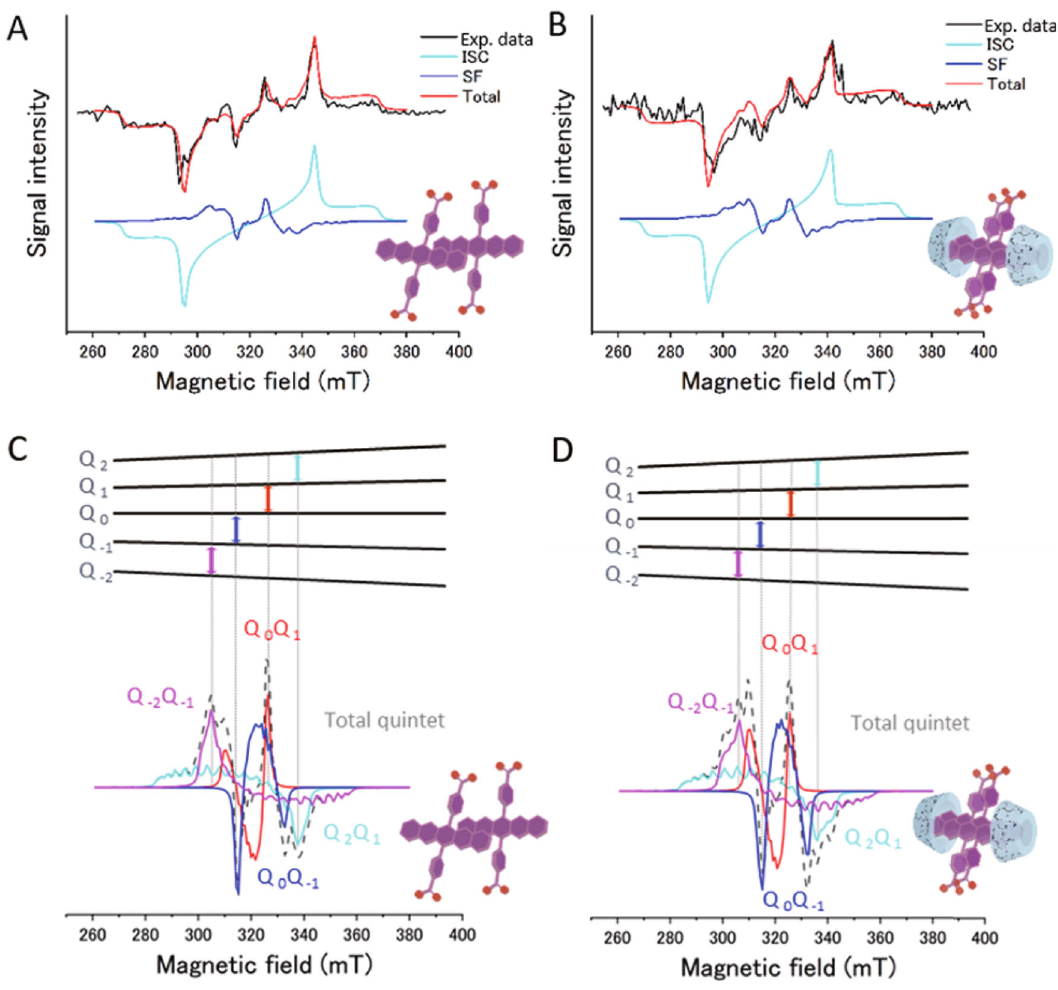
Fig. 4 | Time-resolved ESR measurements of the supramolecular assemblies. Time-resolved ESR spectra of A NaPDBA and B NaPDBA- γ CD in water-glycerol (1:1) at143K([NaPDBA]= 1mM, [ γ CD] = 5mM)justafterphotoexcitationat527nmand simulated spectra of C NaPDBA and D for NaPDBA- γ CD, attributing transitions